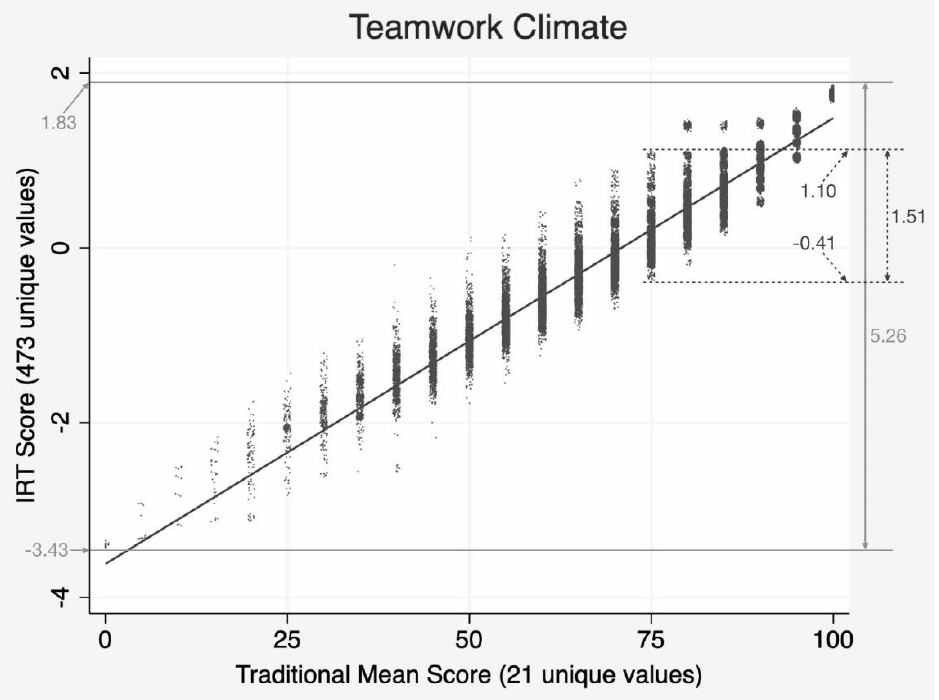
Figure 2. A visual manifestation of the relationship between scoring methods. Note: dots are jittered slightly for a better